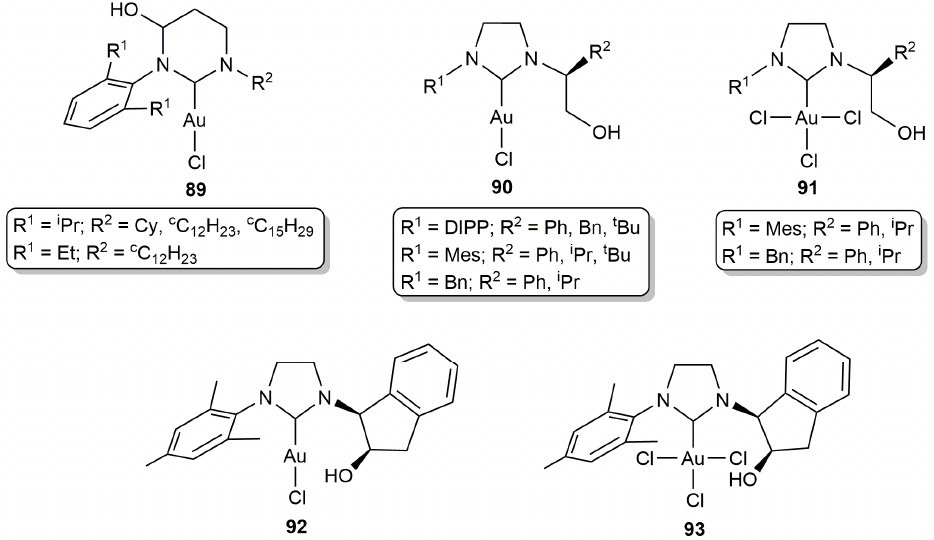
Figure 4. Structure of the hydrophilic bis-NHC gold(I) complexes 86 – 88 .